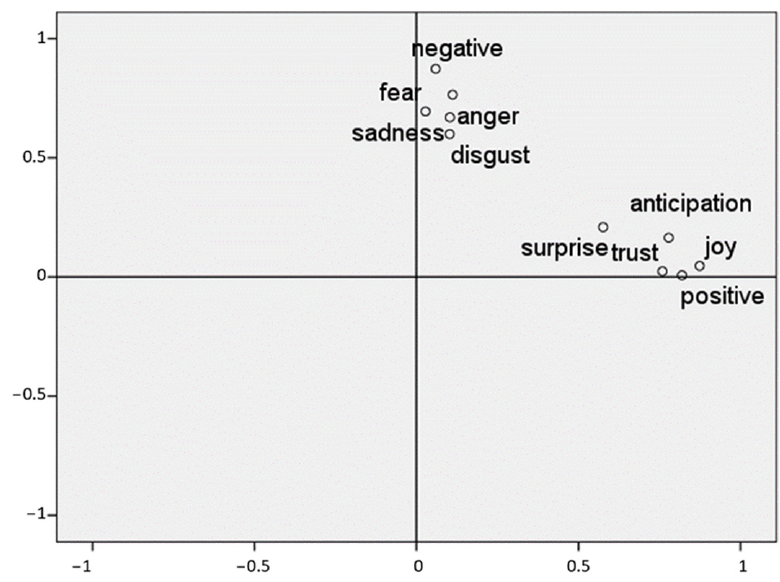
Figure 15. Relationships between the components extracted in the FA , period 1. For the period after the conflict (Figure 16), the factor analysis detected three compo- nents that jointly explained over 78% of the variance. Table 4 presents the pattern matrix that reports the contribution of each variable to the factor and the statistical indicators of the appropriateness of the variables for the FA . The first component was formed by negative sentiment and the emotions of anger, disgust, fear, and sadness. Positive sentiment and the emotions of joy and trust formed the second component. Finally, the third component included the emotions of anticipation and surprise.